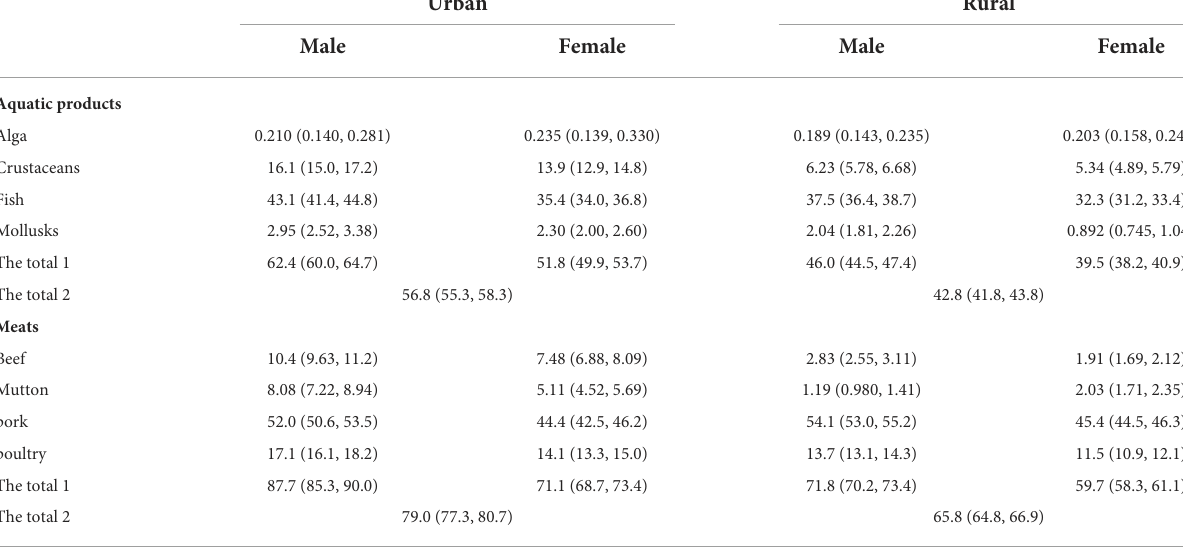
TABLE 4 Daily consumption of aquatic products and meats by gender and region using 24h recalls (g/d) ( n = 24,106) * .